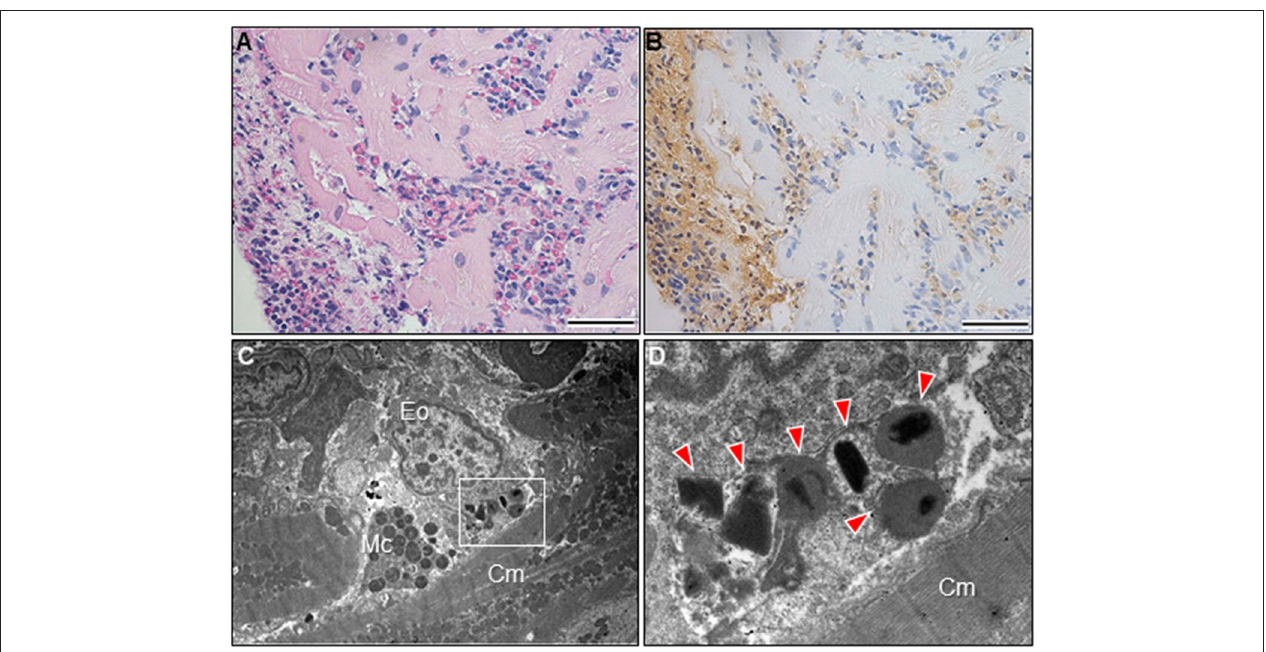
FIGURE 4 | Endomyocardial biopsy findings. Photomicrograph with hematoxylin and eosin stain (A) . The prominent eosinophilic infiltrate with degranulated eosinophils and surrounding edema and the layers of thickening endocardium can be noted. Photomicrograph with immunostaining against the eosinophilic cationic protein (B) . Bars: 50 µ m. Transmission electron microscopy shows myocardial interstitial infiltration by degranulated eosinophils and mast cells in close proximity to cardiomyocytes (C) . A high magnification view of the region outlined by the box in Figure 4C (D) . Eosinophilic granules can be noted (arrowheads). Cm, cardiomyocyte; Eo, eosinophil; Mc, mast